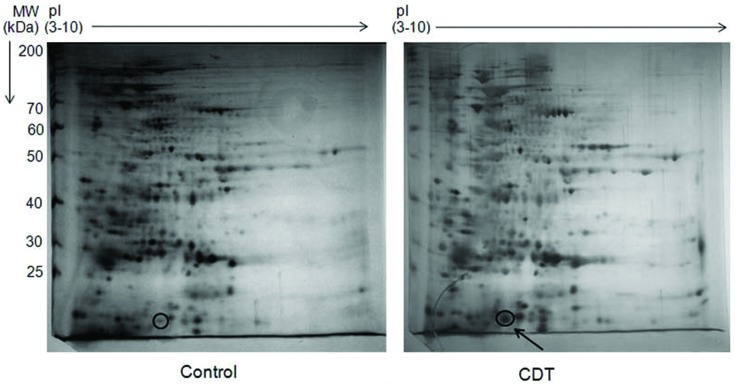
2D profile of rice seed proteins under control and CDT. Total 500 μg of protein from Control and CDT treated seeds (6 days) was used for IEF using a non-linear IPG strip of pH 3–10. Second dimension was run on 12.5% SDS-PAGE and gels were stained with silver stain. Gel images were analyzed with Imagemaster 2D Platinum 7.0 (GE Healthcare) and differentially expressed spots were identified. Encircled spot was eluted and sequenced using MALDI-TOF/TOF.